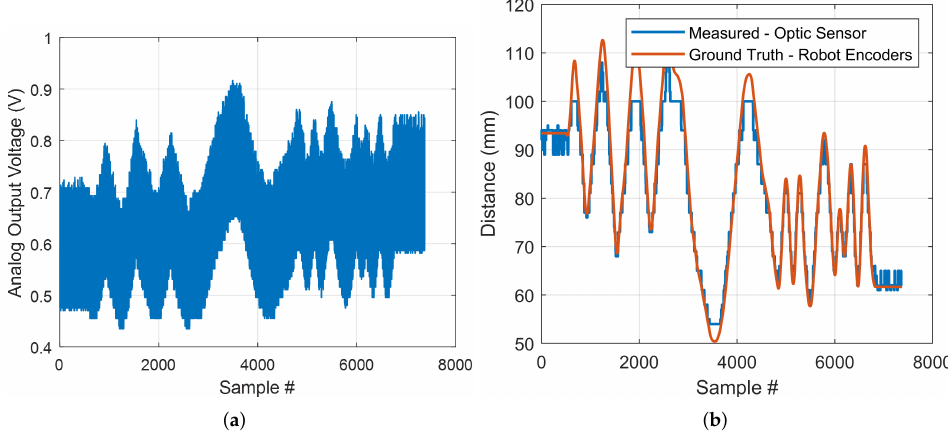
Figure 4. Sample of data collected for distance measurement accuracy evaluation ( a ) sensor’s recorded raw output voltage; ( b ) distance measured by the sensor and the reference